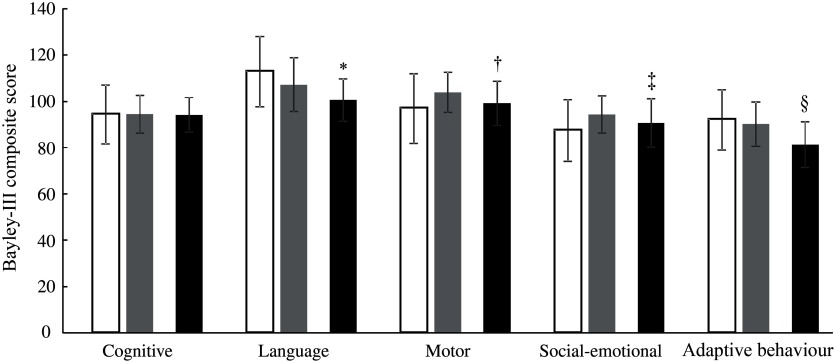
Neurodevelopment (Bayley Scales of Infant and Toddler Development Third Edition (Bayley-III) scores) of the infants in the intervention group at 6 and 12 months of age (IC; n 64) and in the static cross-sectional control group at 12 months of age (CG; n 80). , IC 6 months; , IC 12 months; , CG 12 months. *†‡§ P value (ANCOVA model correcting for sex, exclusively breast-feeding until 6 months of age (yes/no), Kuppuswamy socio-economic status(32), birth weight, gestational age and study site). * Significantly different from IC 12 months (P = 0·001). † Significantly different from IC 12 months (P = 0·022). ‡ Significantly different from IC 12 months (P = 0·005). § Significantly different from IC 12 months (P < 0·001).